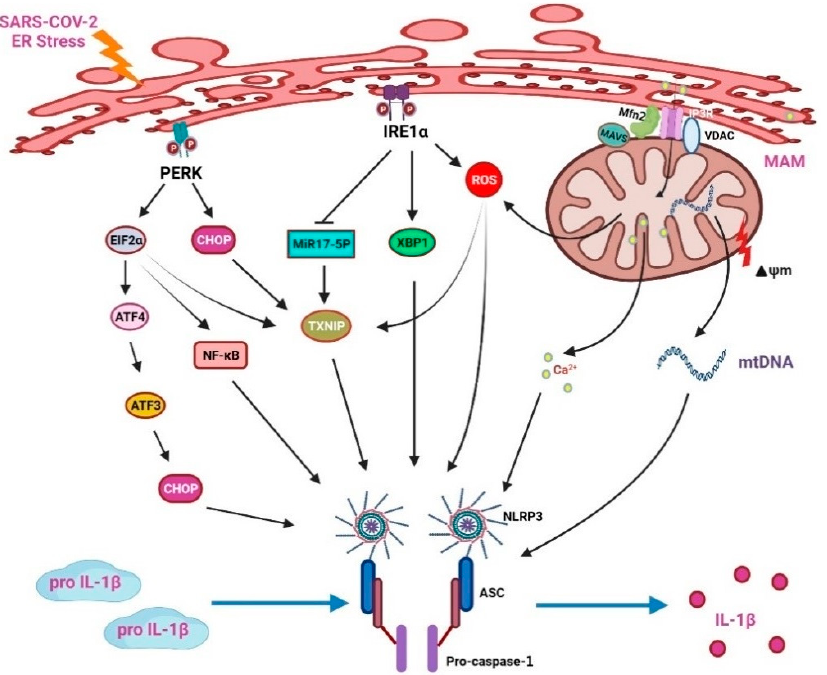
Figure 4. NOD-like receptor protein 3 (NLRP3) inflammasomes mediate ER stress-induced inflammatory responses.